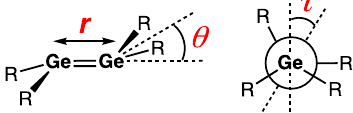
Figure 3. Structural parameters of digermenes (and other multiply bonded organogermanium compounds): bond length, r Ge=Ge ; bent angle θ ; and twist angle τ .